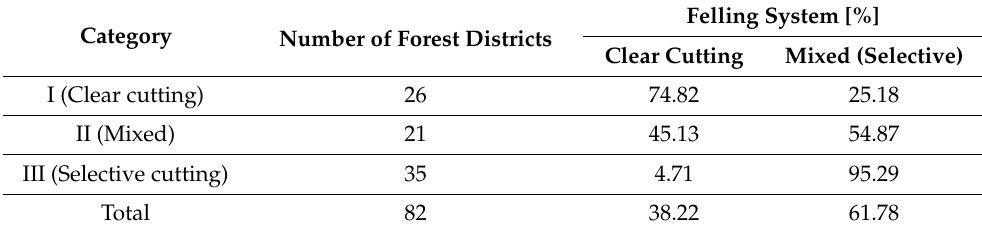
Table A5. Categories of forest districts distinguished on the basis of stand regeneration/felling system.